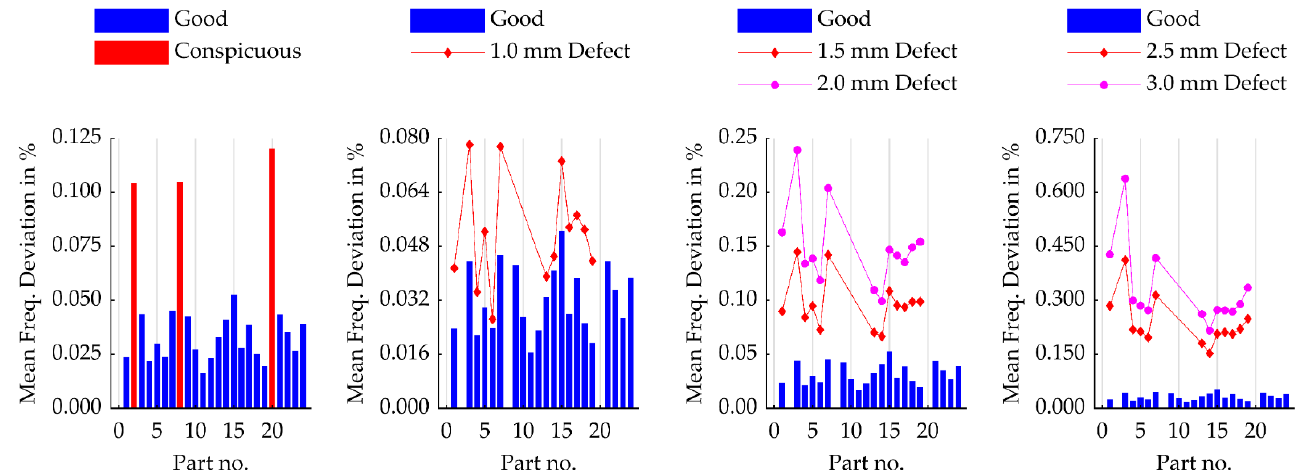
Figure 13. Deviations of model-like predicted eigenfrequencies of machine-made connecting rods versus their ART measured eigenfrequencies depending on part no. and quality state.